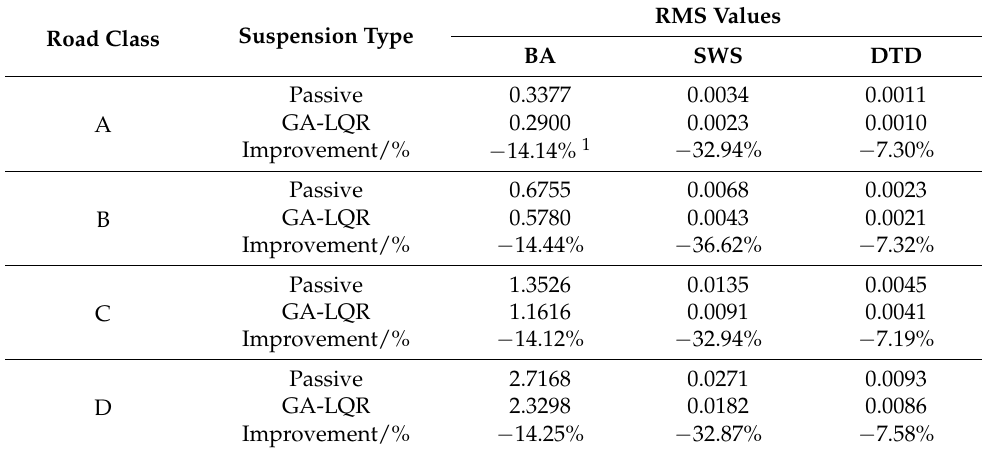
Table 3. RMS values and improvement rate of suspension performance indexes. Road